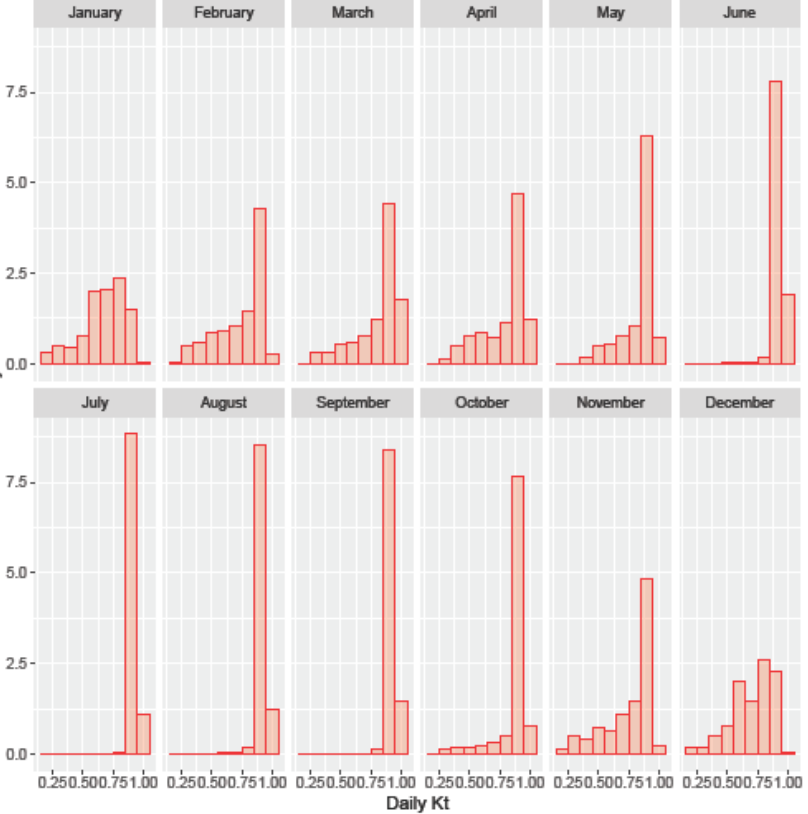
Figure 3. Daily values of clearness index by month.